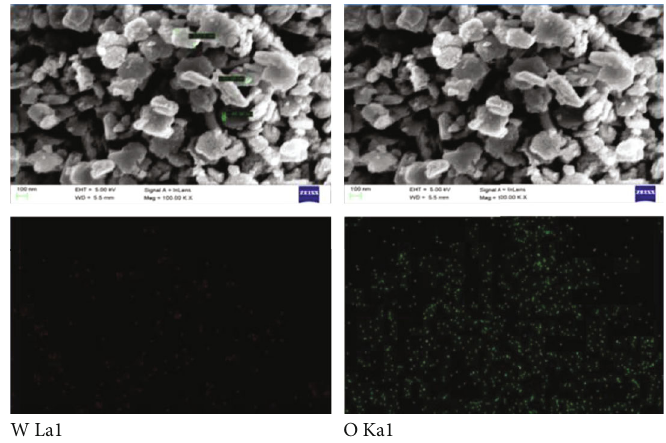
Figure 6: FE-SEM and mapping image of WO